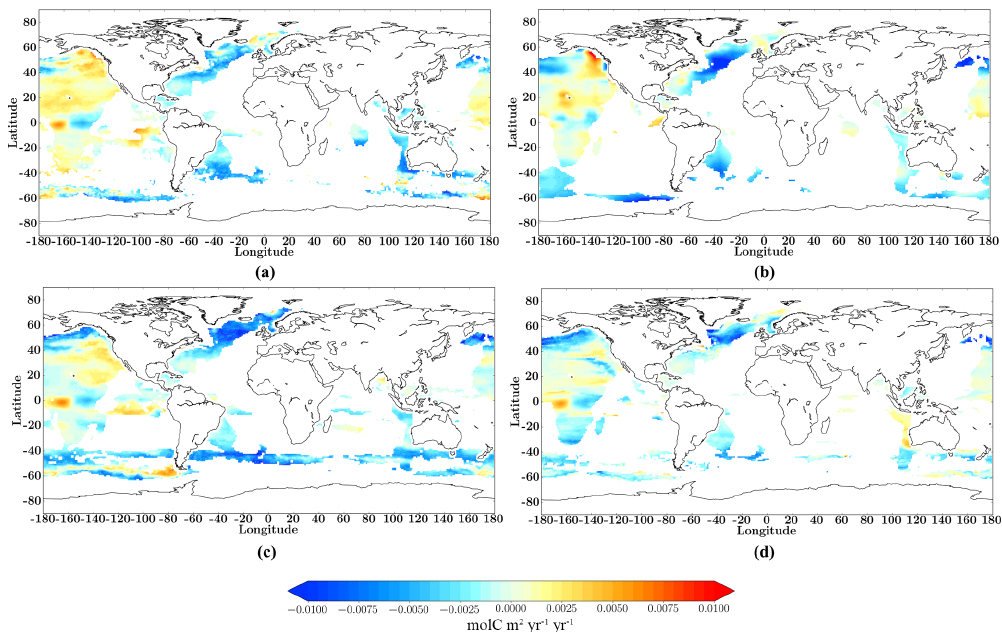
Figure 8. Significant (p_val = 0 . 05) linear trend of f CO 2 for the common period (2001–2015) for (a) LSCE-FFNN, (b) Jena-MLS13, (c) ETH-SOMFFN and (d)